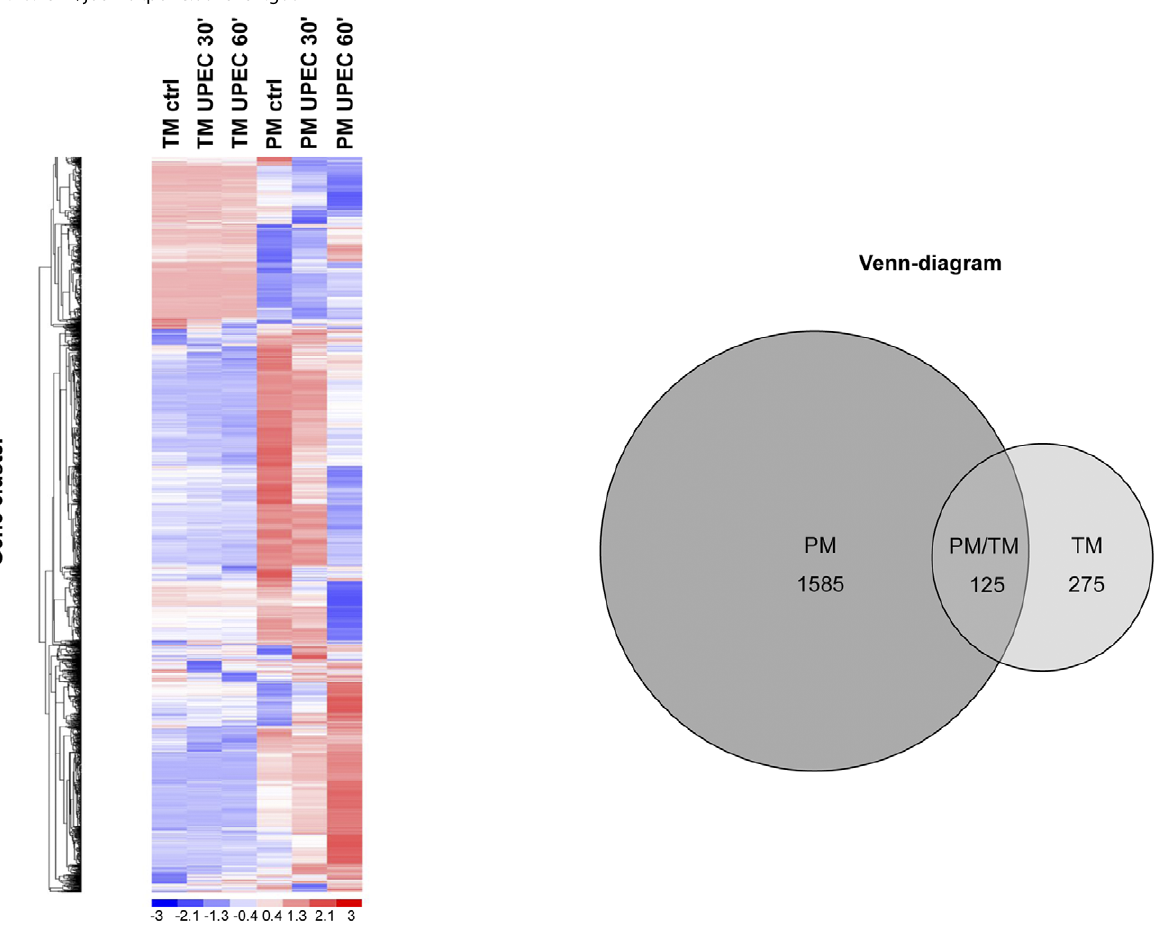
Figure 2. Hierarchical clustering of significantly regulated genes in PM and TM clearly distinguished between PM and TM pretreatment, 30 min and 60 min after infection with UPEC CFT073. ( A ) Blue indicates downregulation and red upregulation of genes. A time-dependent pattern of gene regulation can be observed within the macrophage populations. The picture clearly demonstrates how different PM and TM respond on the gene expression level upon infection with the same UPEC strain. ( B ) Venn diagram of significantly regulated genes in PM and TM. A total of 1710 genes (PM) and 400 genes (TM) were significantly regulated (FDR , 0.05) at both time points 30 and 60 min. Both PM and TM showed an overlap of 125 genes with PM having 1585 unique genes and TM 275 unique genes.